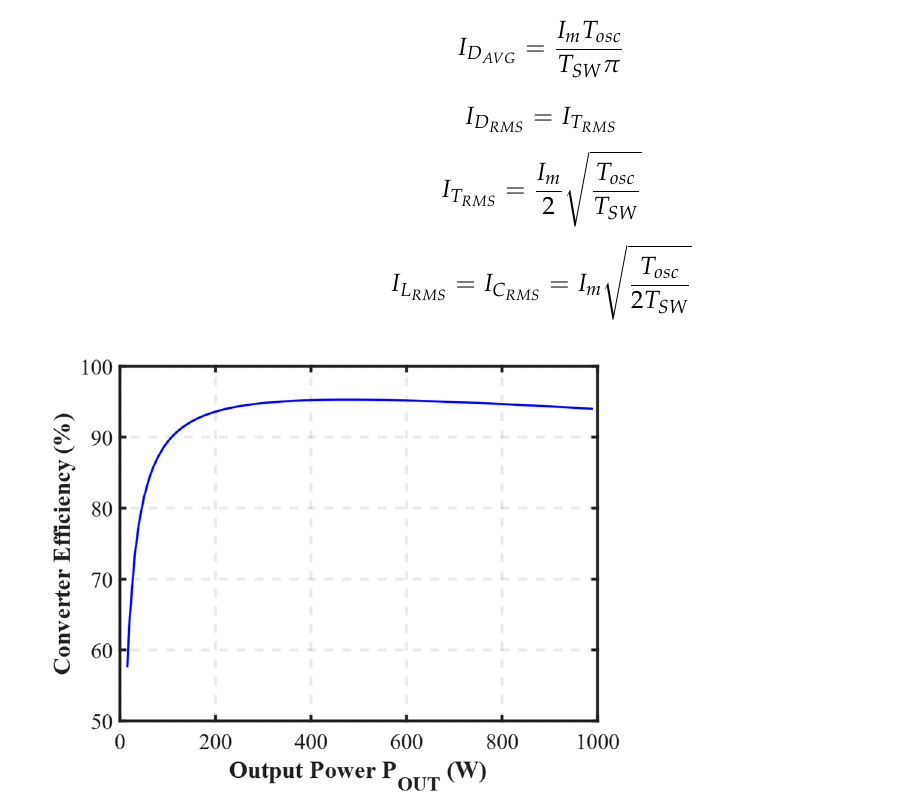
Figure 4. Efficiency curve of the proposed converter drawn based on the derived analytical model.